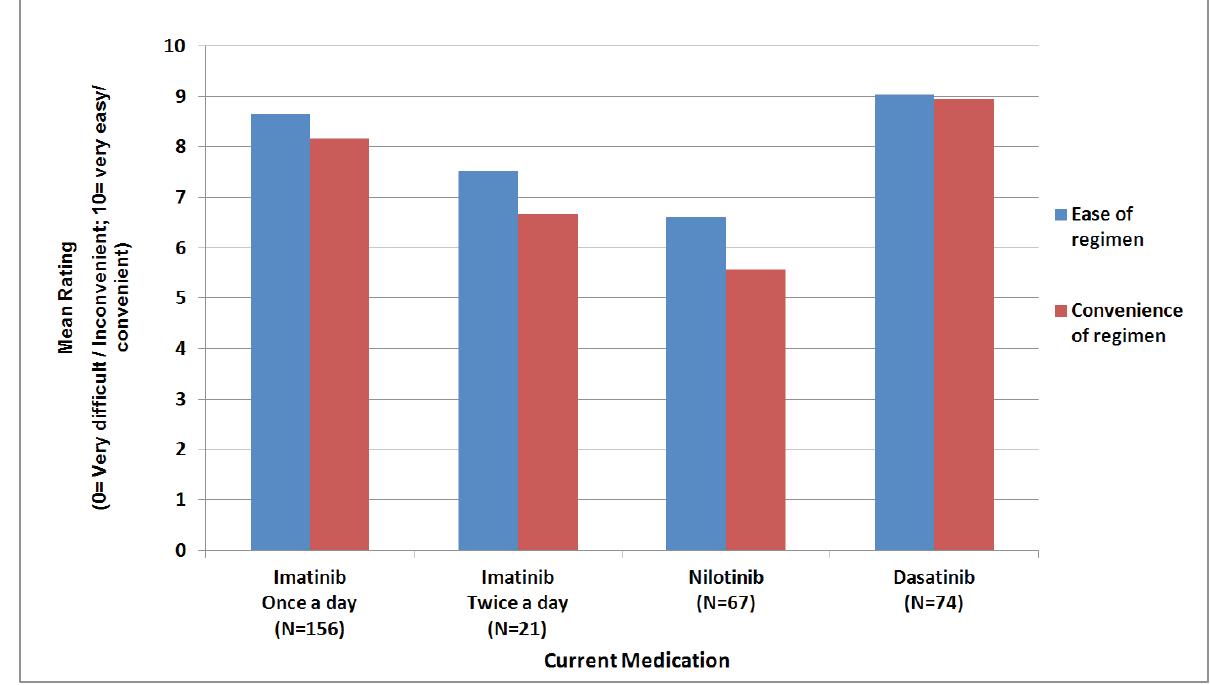
Figure 3. Ease and Convenience of Current Treatment Regimen